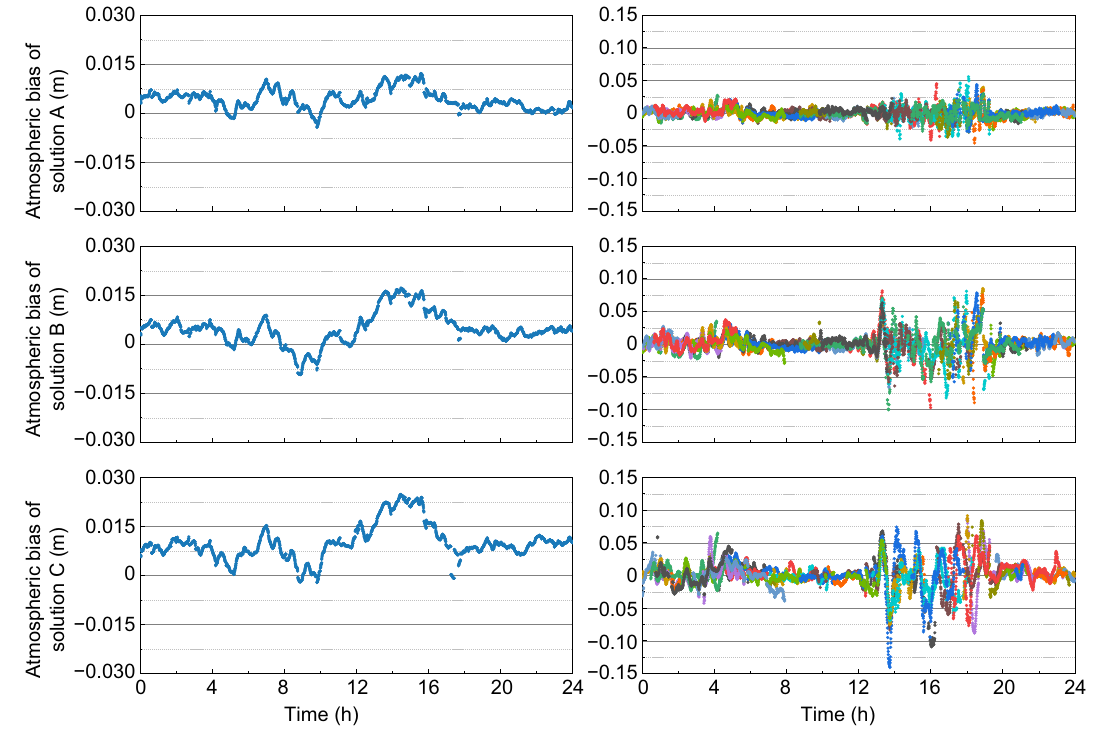
Fig. 3 Atmospheric bias of the three PPP-RTK solutions (left column: troposphere; right column: ionosphere)